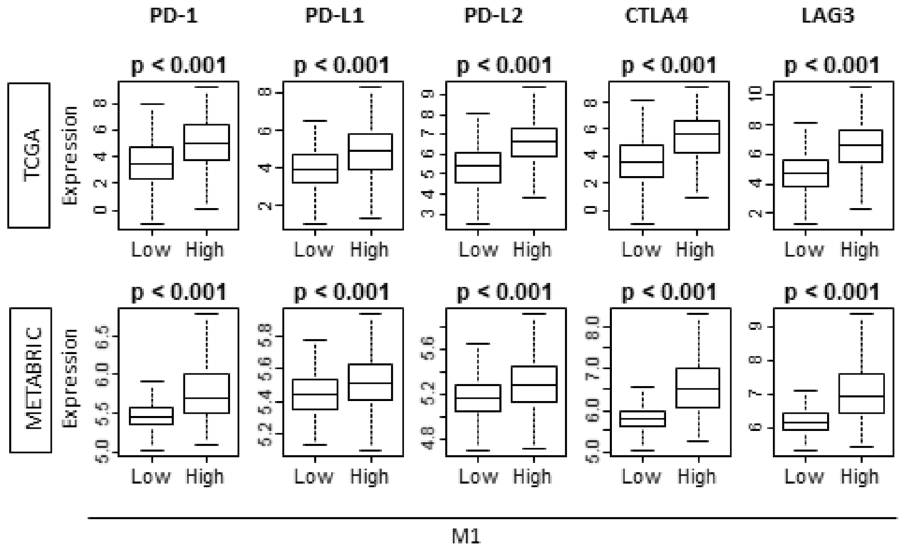
Figure 7. “M1” high tumors demonstrated the association with T cell exhaustion markers in both TCGA and METABRIC cohort. PD-1, programmed death-1; PD-L1/2, (programmed death ligand 1/2); CTLA4, cytotoxic T-lymphocyte-associated protein 4; LAG3, lymphocyte activation gene 3. TCGA (n = 1065, High = 533, Low = 532). METABRIC (n = 1903, High = 953, Low =